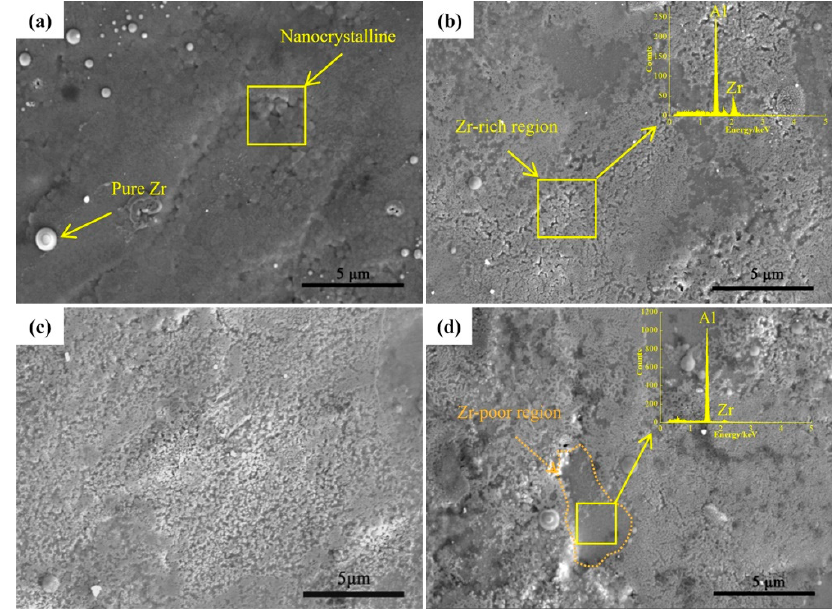
Figure 3. Surface SEM images of samples after HCPEB irradiated: ( a ) 10 pulses, ( b ) 20 pulses, ( c ) 30 pulses, and ( d ) 40 pulses.